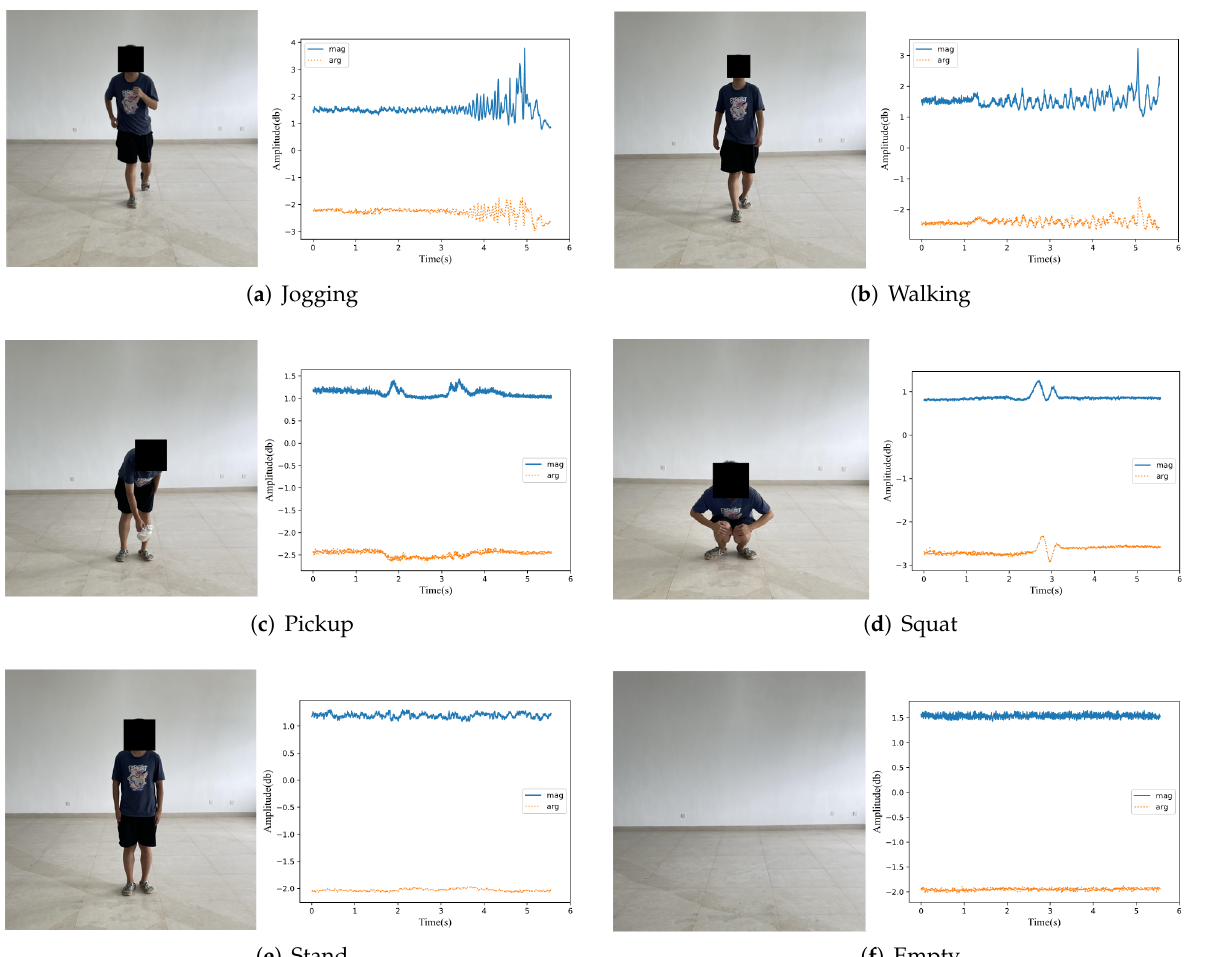
Figure 12. Waveforms of amplitude and phase data for different